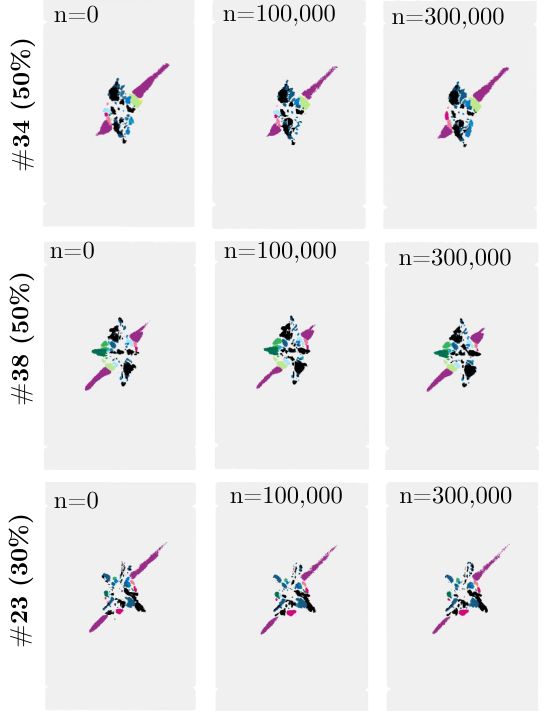
Figure A3. Observation of the delamination growth in the ultrasonic D-scan of selected specimens on the load levels 50% and